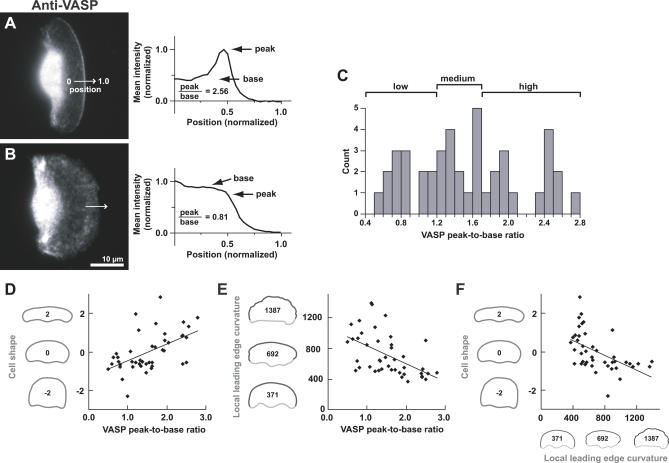
Keratocytes with High VASP at the Leading Edge Are Canoe-Shaped with Smooth Leading Edges(A, B) Using immunofluorescence, VASP intensity levels were measured along lines (∼5 μm wide) positioned across lamellipodia in the middle of cells roughly perpendicular to the leading edge of keratocytes (arrows). The relative levels of VASP at the leading edge of a population of keratocytes were compared using VASP peak-to-base ratios, which were calculated by dividing the highest mean fluorescence intensity at the leading edge (peak) by the lowest mean intensity found interior to the leading edge (base). For cells with low VASP at the leading edge, peak and base positions were assigned based on mean positions from cells (n = 30) with medium or high VASP peak-to-base ratios and thus clear peak and base positions. (A) An intensity linescan shows that VASP is enriched at the leading edge of a smooth cell with a VASP peak-to-base ratio of 2.56. (B) On the other hand, the rough leading edge of a keratocyte has a VASP peak-to-base ratio of 0.81 and thus VASP is practically absent from the leading edge. Scale bar=10 μm.(C) The keratocyte population examined (n = 43) had a wide range of VASP peak-to-base ratio values ranging from 0.5 to 2.8.(D) The shapes of keratocytes were compared using PCA, which identified the major modes of shape variation of polygonal cell contours extracted from intensity-thresholded fluorescent images. A shape mode value of zero corresponds to the mean shape and the negative or positive values correspond to standard deviations describing canoe (+SD) or round D shape (−SD) on the y-axis. Representative cell contours for the specified values are shown on the y-axis. For example, the cells in (A) and (B) have shape mode values of 1.32 and −0.77, showing that they can be quantitatively described as canoe or D shaped, respectively. This shape mode significantly correlates with VASP peak-to-base ratios (r2 = 0.28, p = 0.0002, n = 43, solid line).(E) To compare leading-edge shapes, we measured and normalized their degree of local curvature. Local leading-edge curvature negatively correlates (r2 = 0.28, p = 0.0003, n = 43, solid line) with VASP peak-to-base ratios.(F) A significant negative correlation is also observed between cell shape and local leading-edge curvature (r2 = 0.28, p = 0.0003, n = 43, solid line).